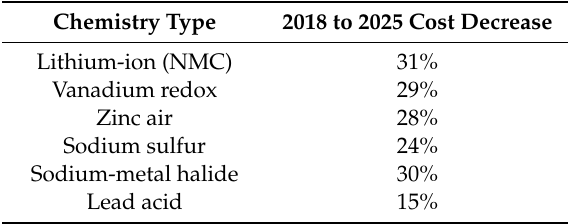
Table 5. Cost Decrease from 2018 to 2025 by Battery